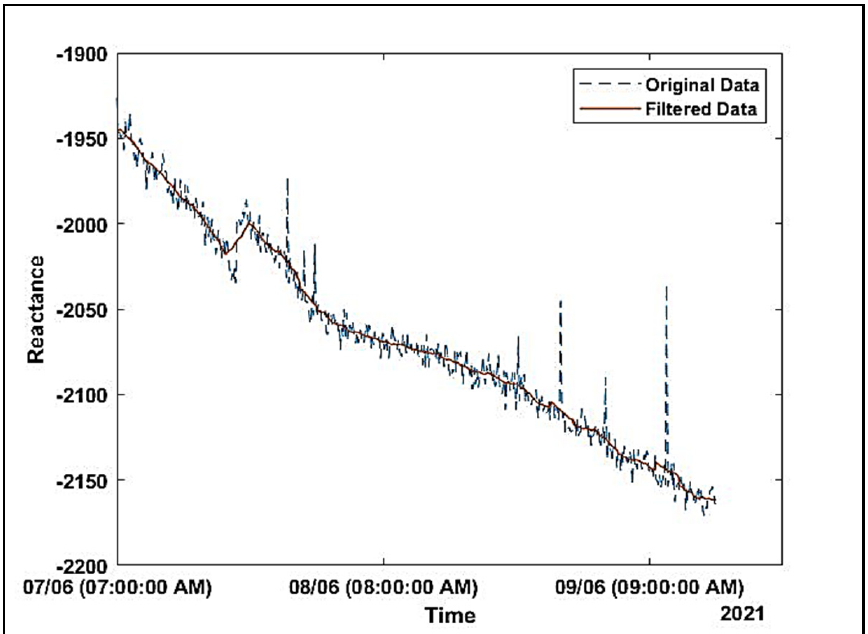
Figure 15. The signals of the MEC sensor recorded for 72 h.